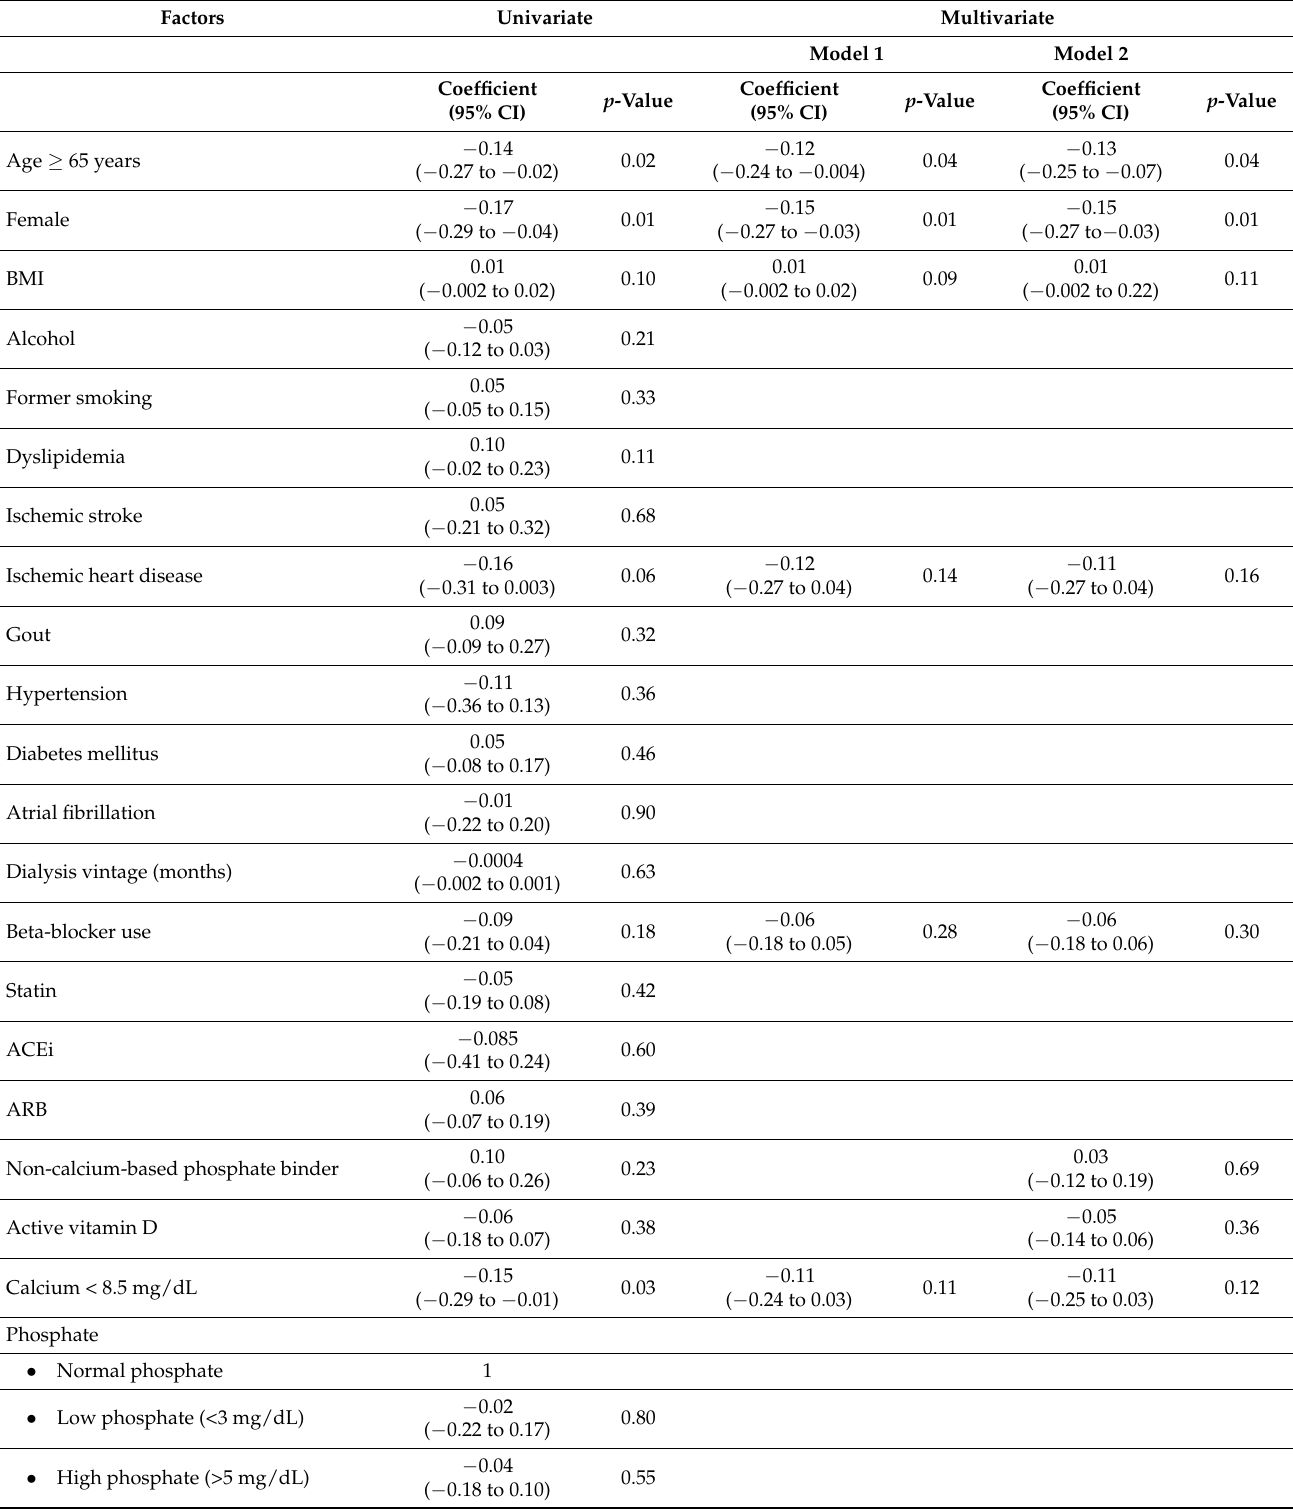
Table 2. Association of beta-blocker use and BMD of the femoral